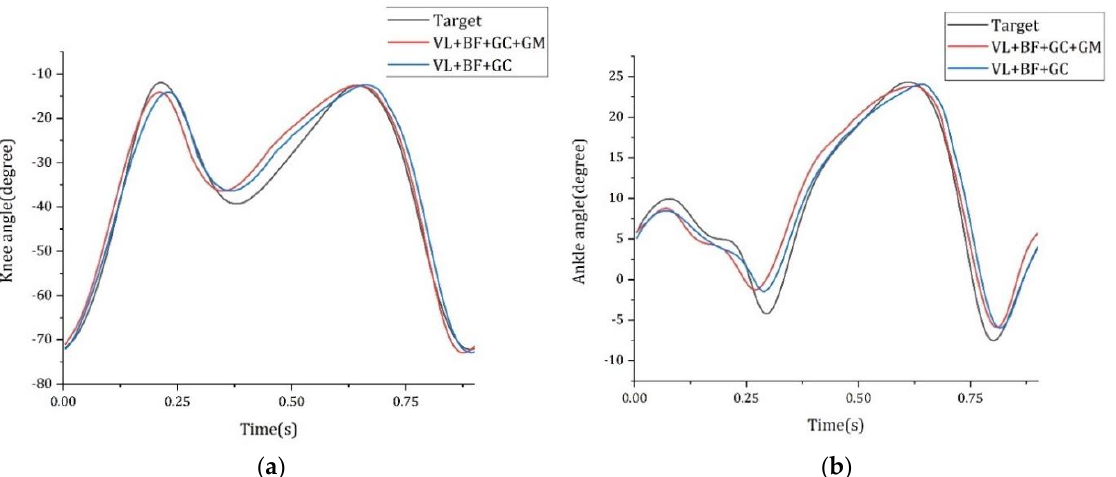
Figure 6. The comparison diagram of the combination VL + BF + GC, the combination VL + BF + GC + GM and the target values for knee ( a ) and ankle ( b ) of the subject AB14.